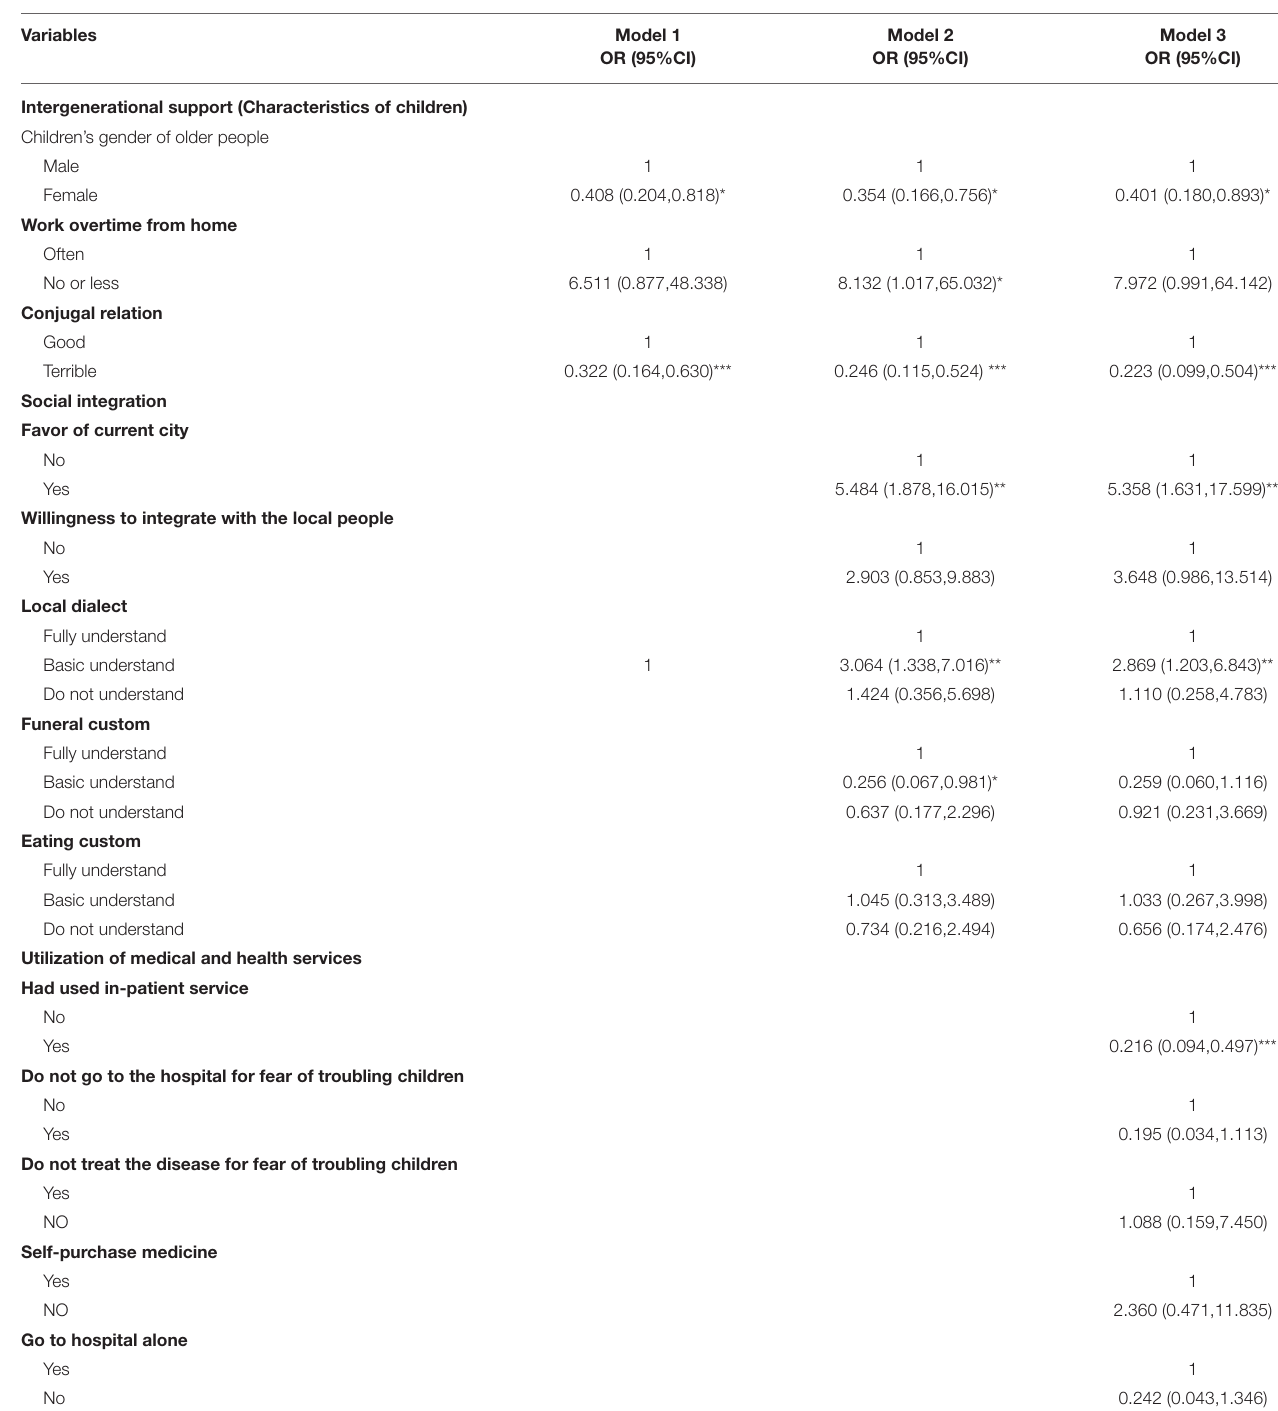
Model 2 OR (95%CI)